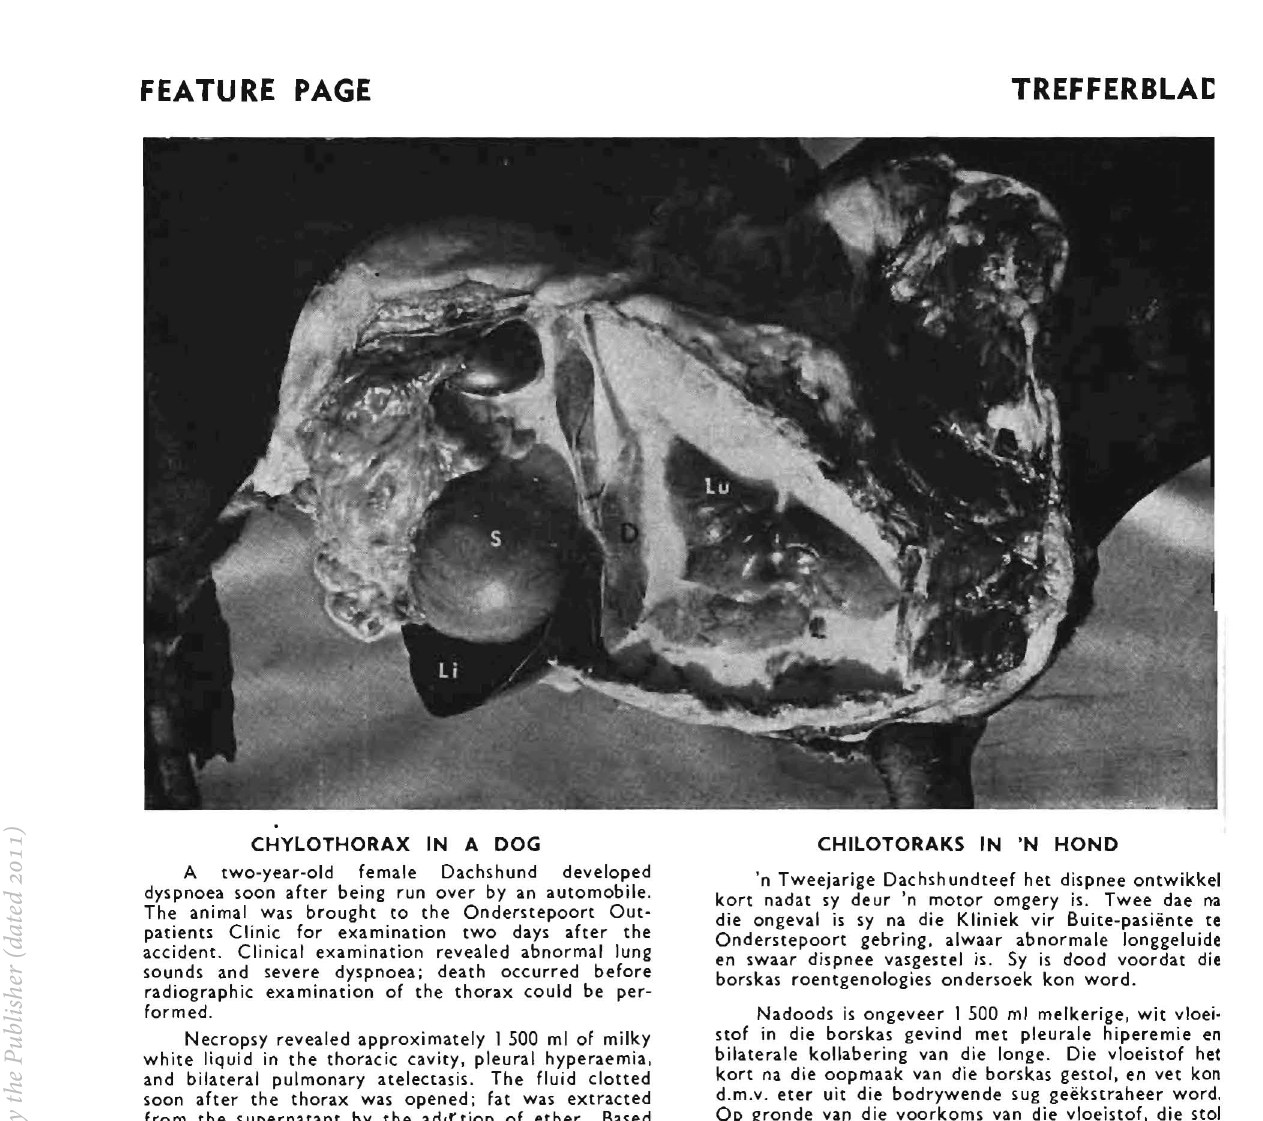
Dachshund developed dyspnoea soon after being run over by an automobile. The animal was brought to the Onderstepoort